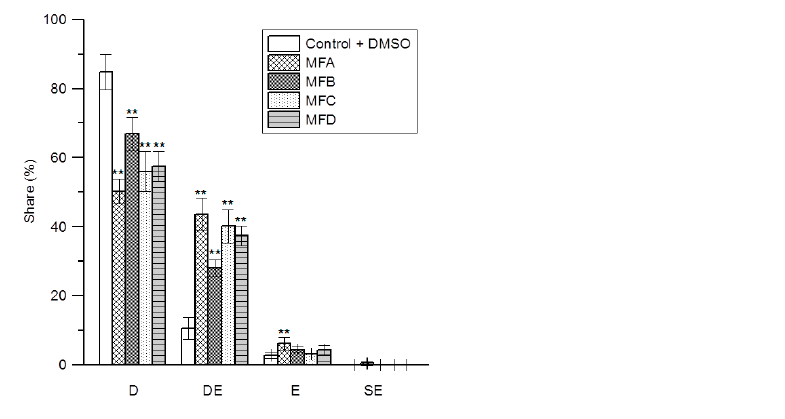
Figure 5. The percentage share of discocytes (D), discoechinocytes (DE), echinocytes (E), and spheroechinocytes (SE) in population of control erythrocytes (C + DMSO) and those modified by MFA, MFB, MFC, and MFD compounds used at 25 µM concertation. The experiment was carried out in three replicates, and the results were presented as mean ± standard deviation. Statistically significant differences are marked: ** α = 0.01.